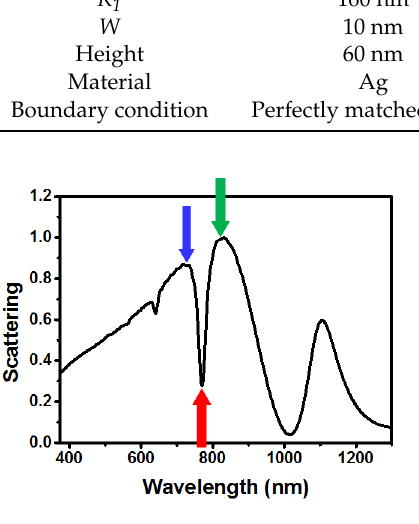
Figure 6. Scattering spectrum of the disk-ring nanostructure, where the curve is normalized according to the peak value. The red, green, and blue arrows denote the wavelengths of the pump (probe), Stokes, and anti-Stokes lights, respectively.